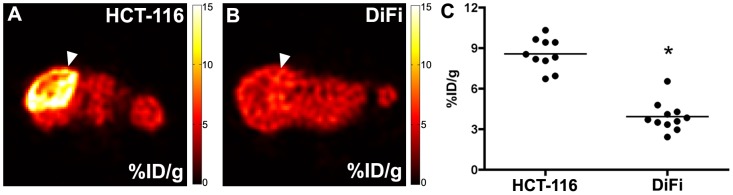
Static [18F]-FLT PET uptake is 2-fold greater in HCT-116 xenografts than DiFi xenografts.Representative 20 minute static PET scans reflect the relative 60 minute accumulation of [18F]-FLT (%ID/g) qualitatively and show increased tracer uptake in HCT-116 xenografts (A) compared to DiFi (B) xenografts (tumor localized by arrowhead). Spatially, %ID/g maps (A,B) are similar to KFLT maps derived from parametric modeling (
Fig. 3C,F
). Static PET imaging reveals approximately a 2-fold increase in [18F]-FLT accumulation in HCT-116 xenografts (8.56 ± 1.17 %ID/g) compared to DiFi xenografts (3.92 ± 1.08 %ID/g; p < 0.0001) (C) and was similar to [18F]-FLT flux (KFLT) means derived from compartmental modeling (
Table 1
).